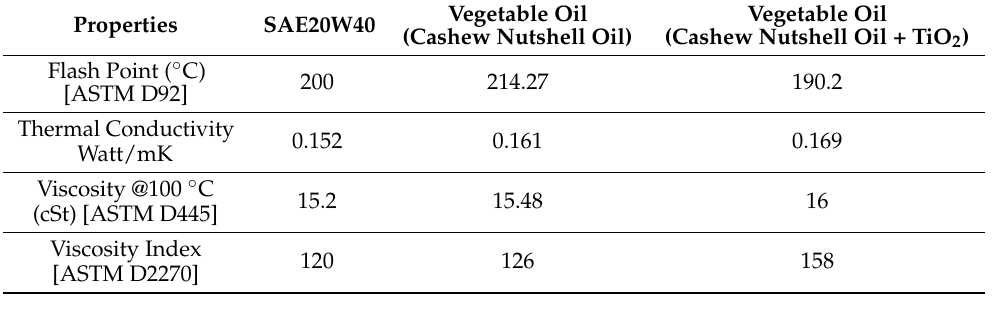
Table 2. Properties of lubricants used.